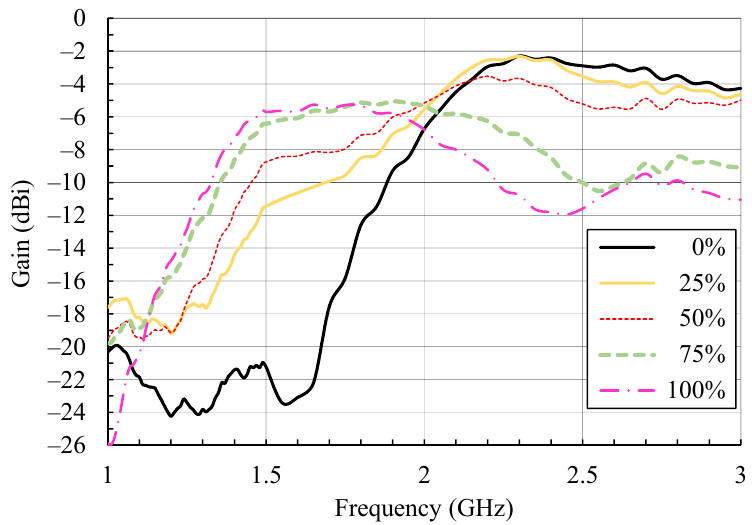
Figure 6. Measured gain of the textile PIFA for different moisture contents [13,16].